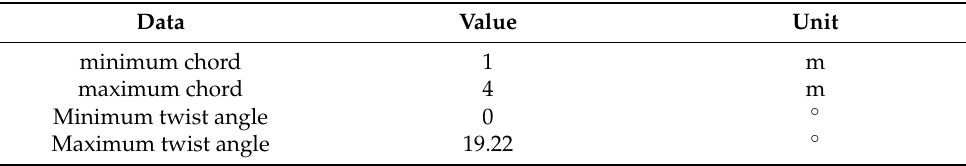
Table 1. Data on the physical characteristics of the wind turbine blade. Data